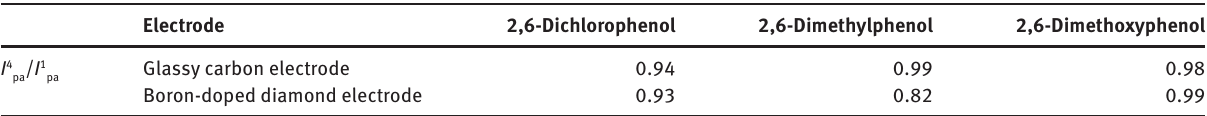
/ I 1 values for selected phenols at a glassy carbon electrode and a boron-doped diamond electrode with an acidic methanol Table 1: I 4 pa pa electrolyte (Narmadha et al.